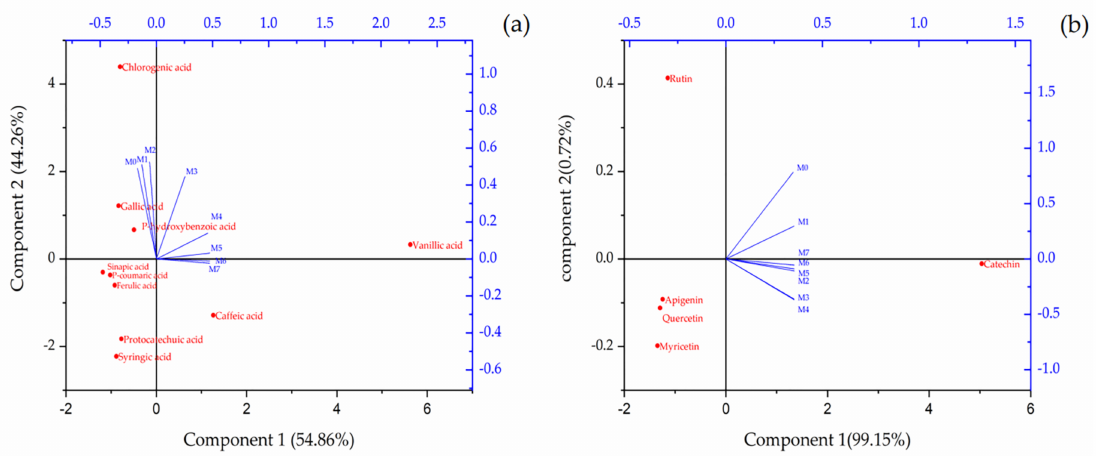
Figure 3. ( a ) PCA score plot of phenolic acids and ( b ) PCA score plot of flavonoid compounds. M0 − M7 are mulberry fruits during ripening